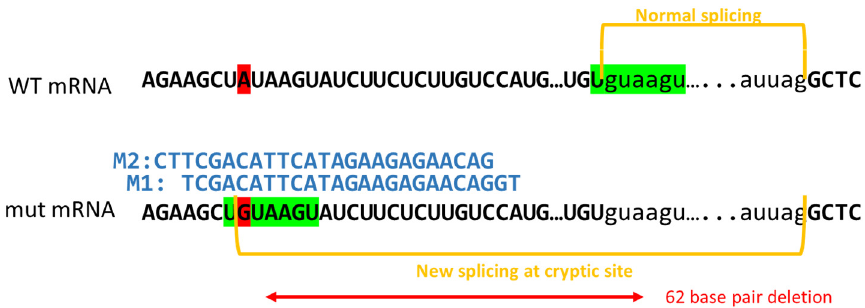
Figure 1. Pathogenic patient-specific variant c.1466A>G; p.Y489C alters splicing. Schematic of wild type (WT) and mutant exon 13 sequence surrounding c.1466. The top line depicts WT mRNA transcript with c.1466A highlighted in red. Exonic sequences are denoted by capital letters and intronic sequences are in lower case font. Normal spicing occurs at the canonical 5 ′ and 3 ′ splice sites denoted by “gu” and “ag” and is indicated with yellow brackets. The 5 ′ recognition sequence is highlighted in green. The mutant mRNA transcript is represented below with the A>G variant highlighted in red. Notably, this creates an alternative 5 ′ splice site denoted by the canonical “GU” sequence. The recognition sequence is again highlighted in green and is identical to that in the WT transcript. Yellow brackets again denote where splicing occurs and the resultant 62 base pair deletion that leads to a frameshift is indicated by a red arrow. Morpholinos M1 and M2 are also depicted above the variant transcript to show where they bind to mask the cryptic 5 ′ splice site.